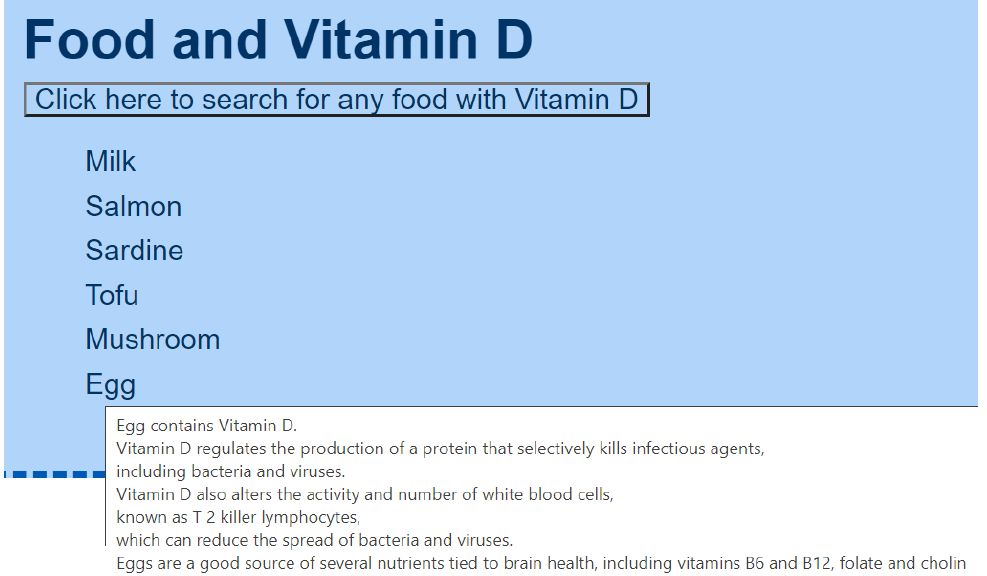
Figure A11. Food that contains Vitamin D.